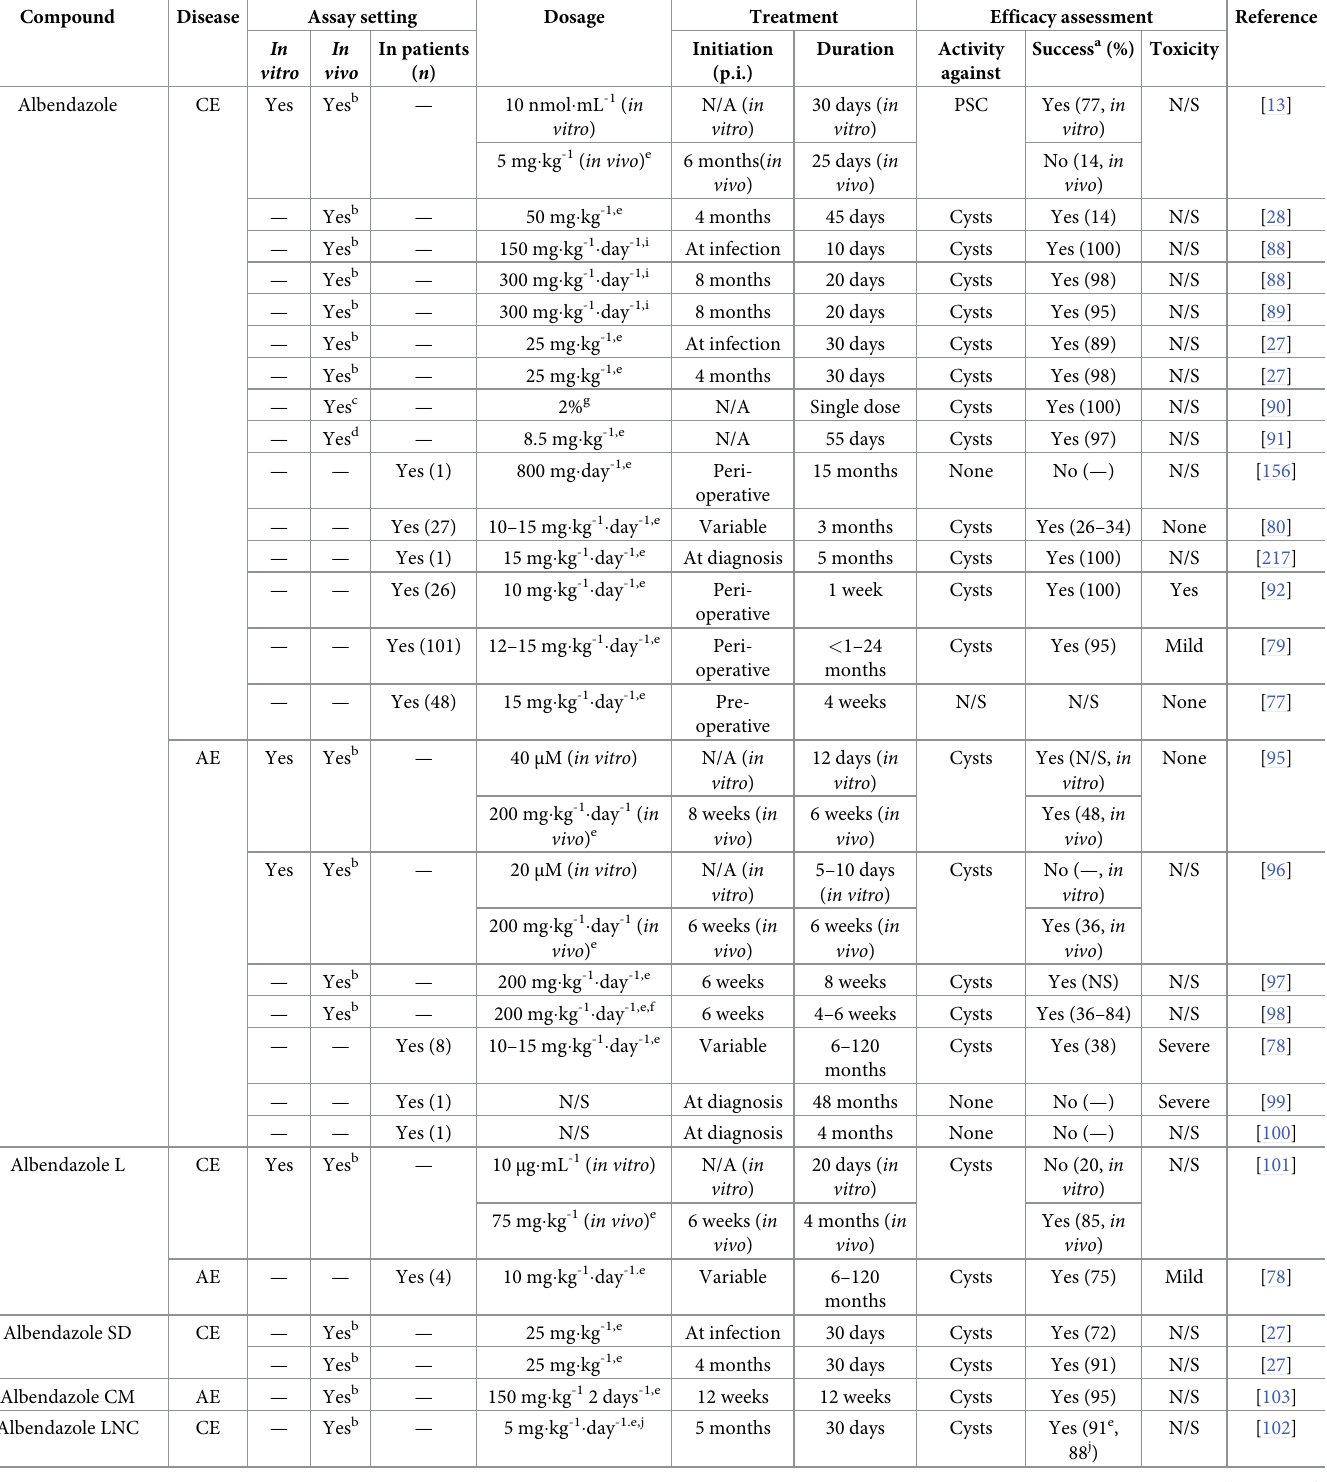
Table 1. Characteristics of benzimidazole compounds, including their metabolites and solubility-improved formulations, as monotherapy for the treatment of cys- tic and alveolar echinococcosis based on the published literature from 2008 to date.